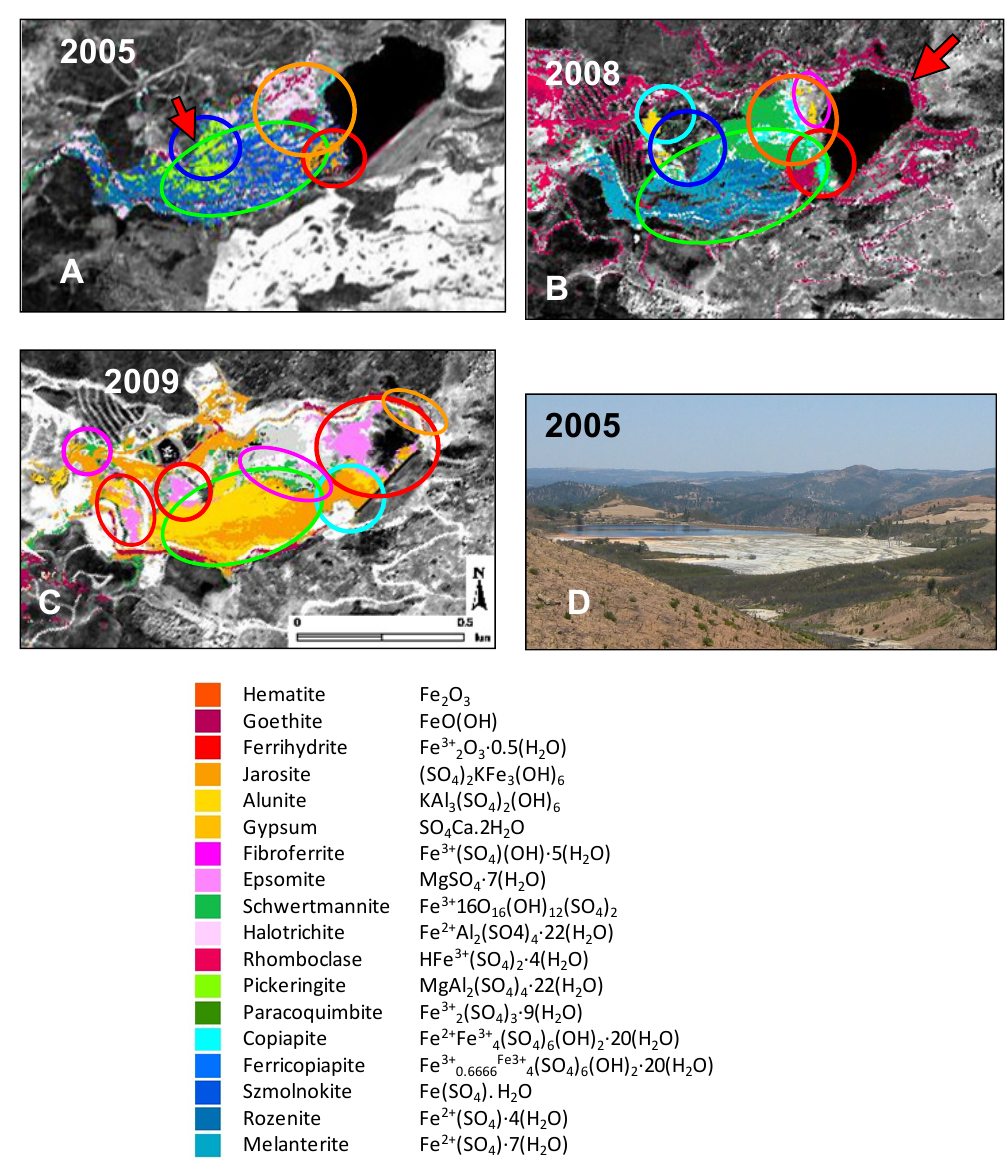
Figure 5. The mill tailings dam: ( A – C ) Maps compiled from HyMap data on the minerals product of oxidation and dehydration of sulfide sludge, on the three available flights on the southern mill tailings dam. Color coding for minerals mapped with the corresponding chemical formula are arranged in a precipitation and oxidation sequence. Bluish and greenish colors concentrate on comparatively hydrated areas. Orange and dark red color corresponds to oxidized end members. Acid water stored behind the wall of the dam is in black. Red arrows are the locations of the mud supply. ( D ) Panoramic view of the mill tailings